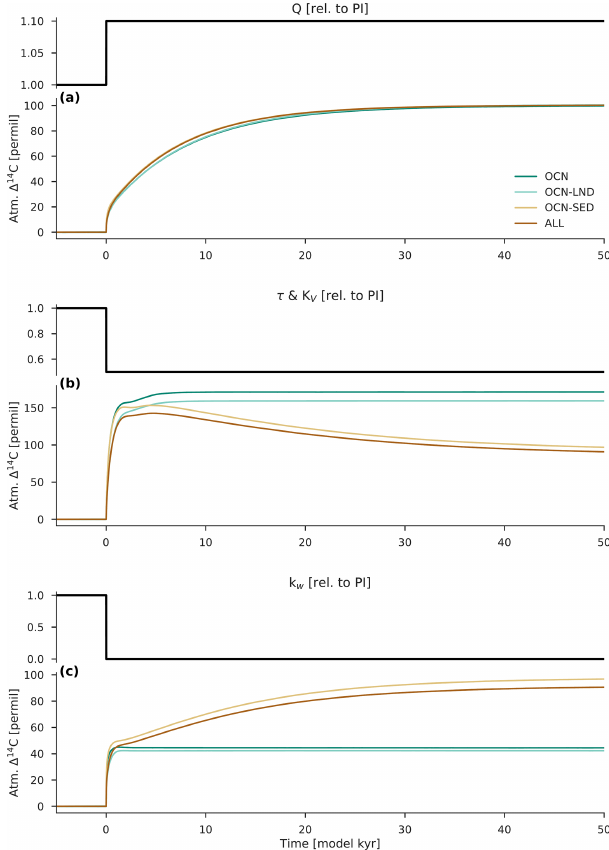
Figure 4. Response of atmospheric (cid:49) 14 C to step changes in 14 C production, followed by step changes in the tunable model param- eters of the ocean carbon cycle. (a) 14 C production Q is increased at time 0 from 100% to 110% of its preindustrial value (“higher production” scenario). (b) Wind stress scale factor τ and vertical diffusivity K V are decreased at time 0 from 100% to 50% of their preindustrial values (“reduced deep ocean ventilation”